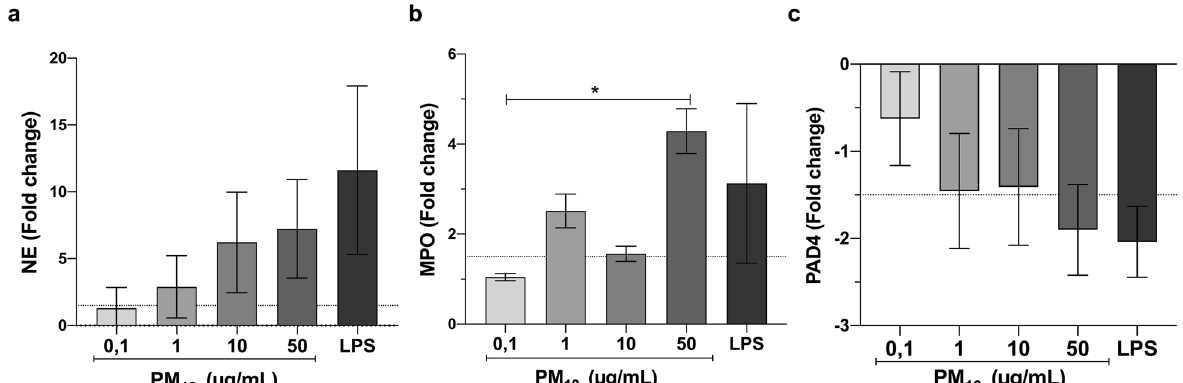
Figure 4. PM 10 exposure alters NETS-associated gene expression in PMNs. mRNA expression of ( a ) NE ( b ) MPO and ( c ) PAD 4 in PMNs exposed to different concentrations of PM 10 (0.1, 1, 10 and 50 µg/mL) for 5 h. Negative control (culture medium); positive control (50 ng/ml LPS). The dotted line illustrates the value of 1.5-fold change compared with the untreated negative control. All data are represented as mean ± SEM of 15–18